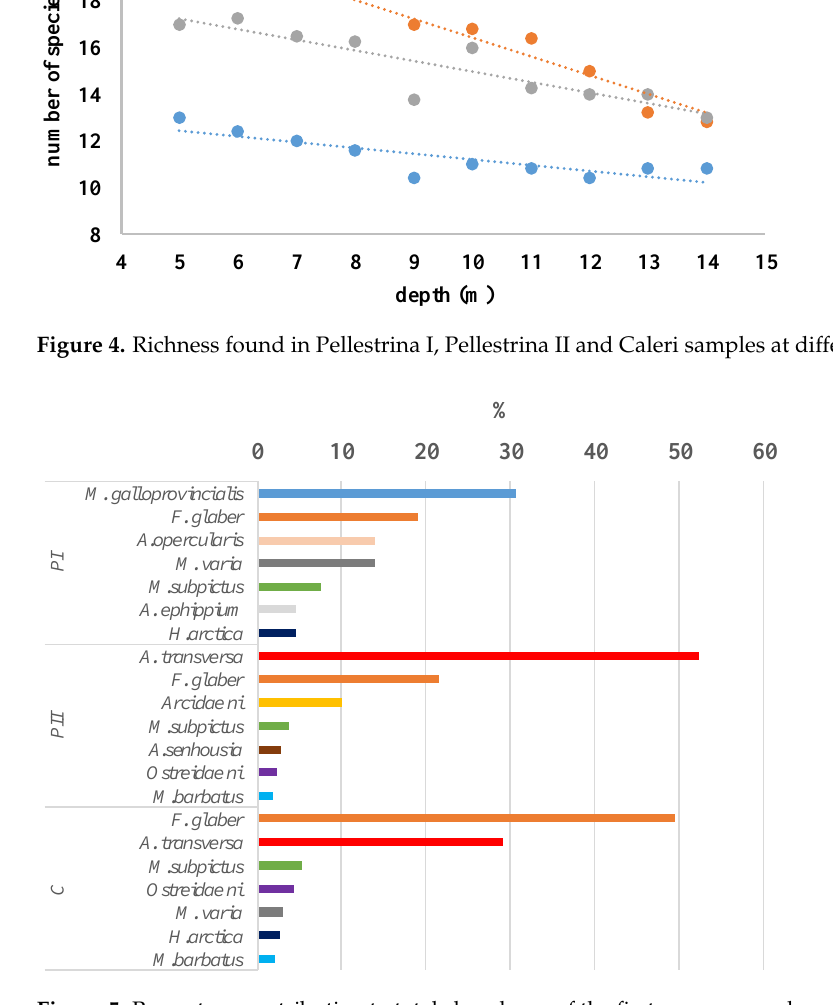
Figure 5. Percentage contribution to total abundance of the first seven more abundant species in each sample: Pellestrina I (PI), Pellestrina II (PII) and Caleri (C). Table 2. List of total bivalve recruits and their relative abundance (m −2 day −1 ), collected by net bags deployed in spring – summer in Pellestrina (PI) and in summer – autumn in Pellestrina (PII) and Caleri (C). n.i. not identified species. For each taxon the most abundant recruitment is in bold.